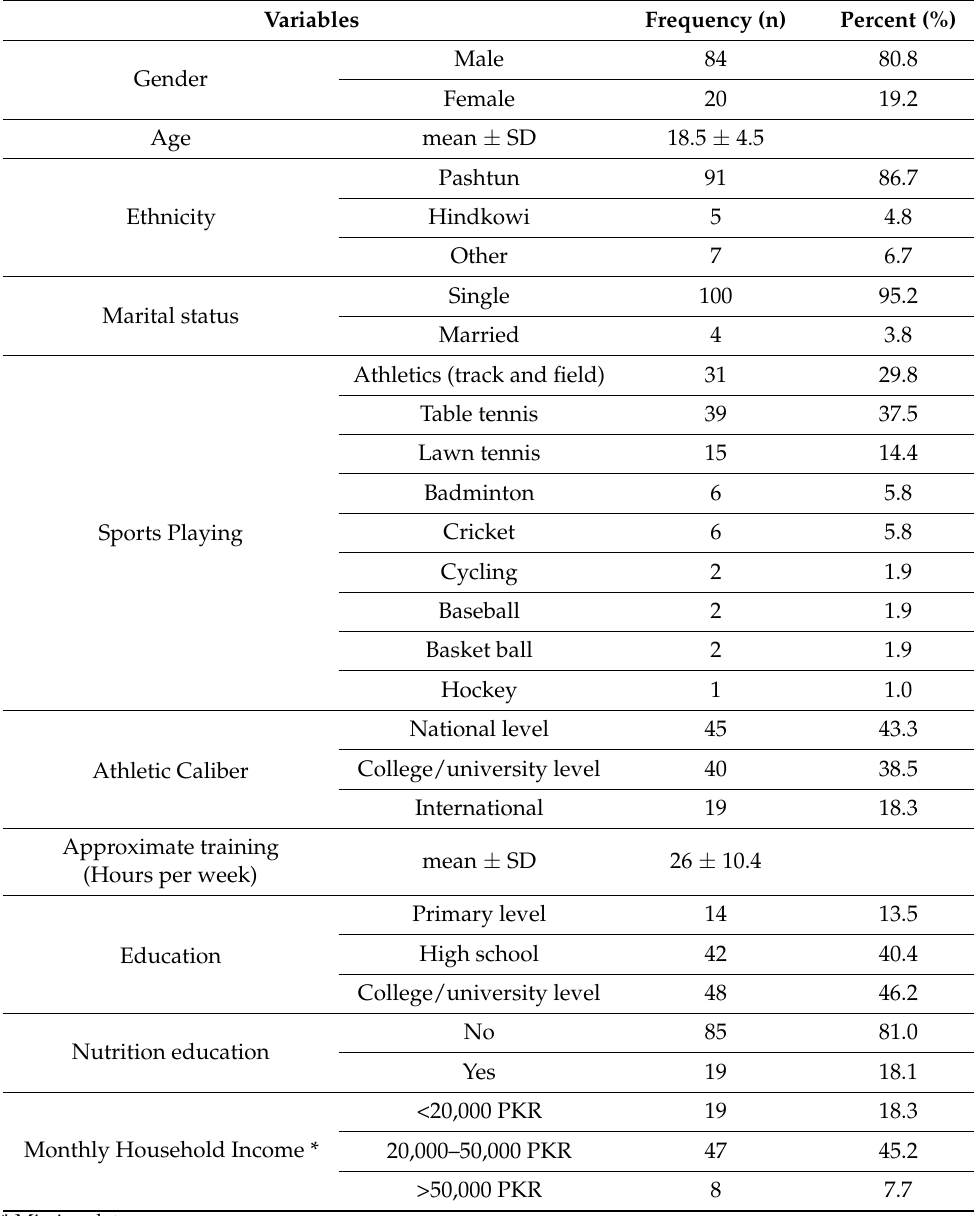
Table 1. Background information of the